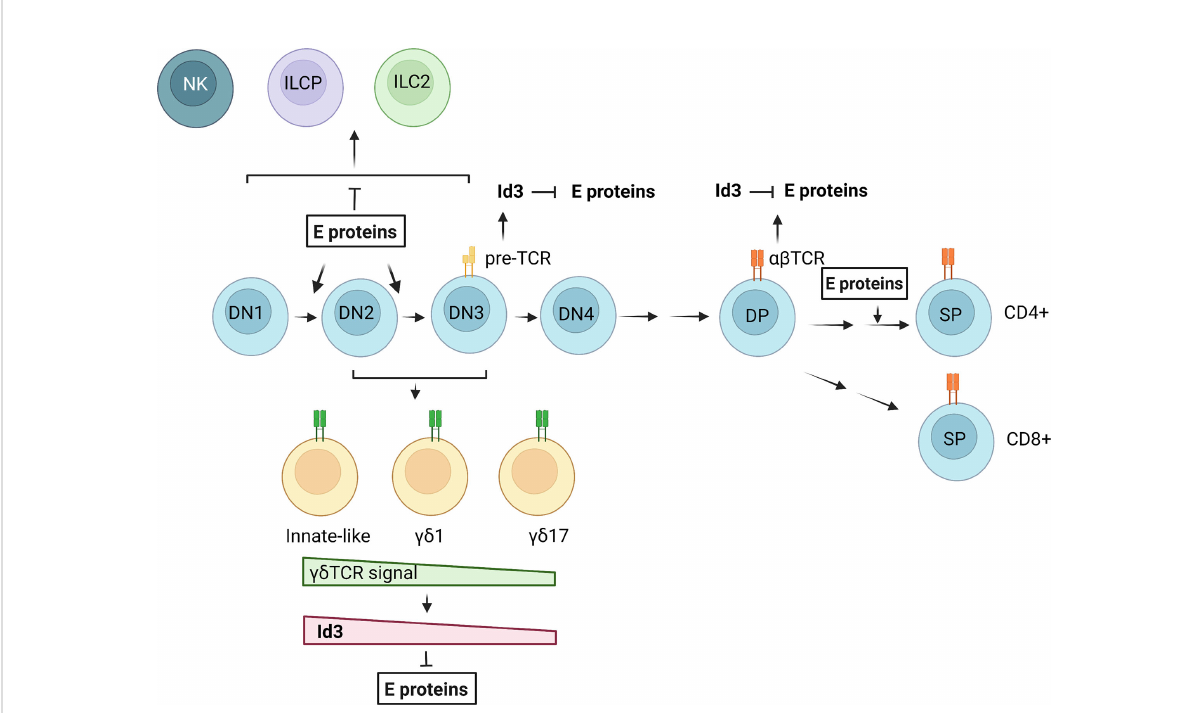
FIGURE 2 Regulation of T cell and ILC differentiation by E and Id proteins. E proteins promote T cell commitment and differentiation from DN1 to DN3 stages. Pre-TCR and TCR signaling in ab T cells lead to transient Id3 up-regulation and E protein inhibition. In gd T cell development, a gradient of gd TCR signal determines the outcomes of different gd subsets through regulation of Id3 expression and E protein activities. NKs, ILC2s and ILC precursors (ILCPs) may arise in the DN stages when E protein functions are suppressed. The fi gure was created by